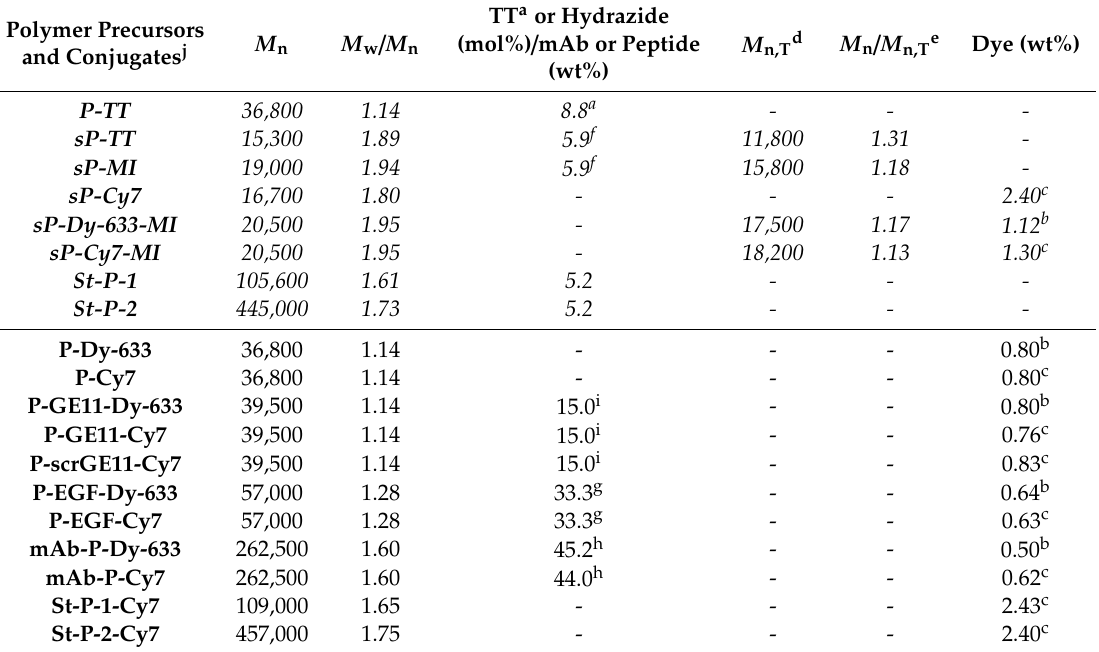
Table 1. Characteristics of polymer precursors and